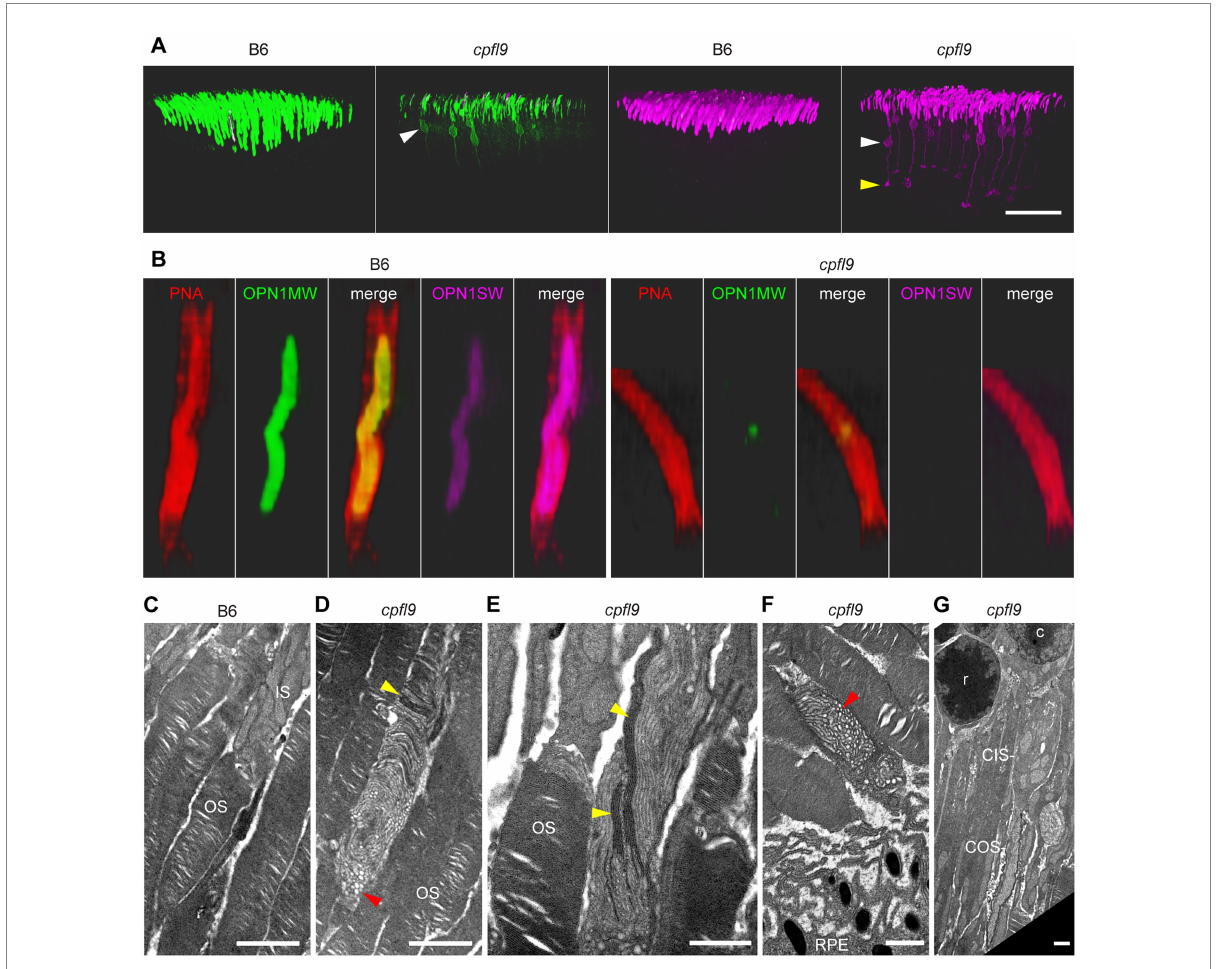
FIGURE 6 Opsin mislocalization and cone OS dysmorphology. (A) Confocal imaging of retinal flatmounts as described in Figure 5. In B6, OPN1MW (green) and OPN1SW (magenta) staining is observed only in the cone OS. By contrast, staining in cpfl9 retinas is observed in cell bodies (white arrowheads) and structures toward the photoreceptor synapse. OPN1SW mislocalization reaches the cone pedicles (yellow arrowhead). Display settings were adjusted identically for all images in Imaris to emphasize opsin mislocalization. Scale bar, 50 μ m. (B) Opsin deficit within the cone matrix sheath. A single cone OS from the stained B6 and cpfl9 flatmounts was viewed in Imaris. In B6 cones, often both OPN1MW and OPN1SW staining were associated with PNA staining (red). By contrast, most cone sheaths in cpfl9 flatmounts exhibited little cone opsin staining. (C–G) Ultrastructure of the outer retina in mice at 6 weeks of age by transmission electron microscopy. (C) Photoreceptor IS and OS in a B6 retina. Stacked disks were evident in the marked OS and in neighboring OSs. (D) An OS-like object in a homozygous cpfl9 retina included disorganized membranes appearing as vesicles and tubules (red arrowhead). A few disks were stacked perpendicular to the OS axis as in B6 mice (yellow arrowhead). (E) Stacked membranes in OS-like objects of cpfl9 mice were often much longer than in B6 mice and were oblique to the OS axis (yellow arrowheads). (F) OS-like objects exhibiting disorganized membranes (red arrowhead) were sometimes found in close proximity to RPE apical microvilli. (G) A cpfl9 cone cell traced from its nucleus (c) included a disorganized OS containing oblique lamellar structures as in E . Images are representative of n = 4 cpfl9 and n = 4 B6 controls. IS, inner segment; OS, outer segment; CIS, cone inner segment; COS, cone outer segment; RPE, retinal pigmented epithelium; c, cone cell nucleus; r, rod cell nucleus. Scale bars: C-G, 1 μ